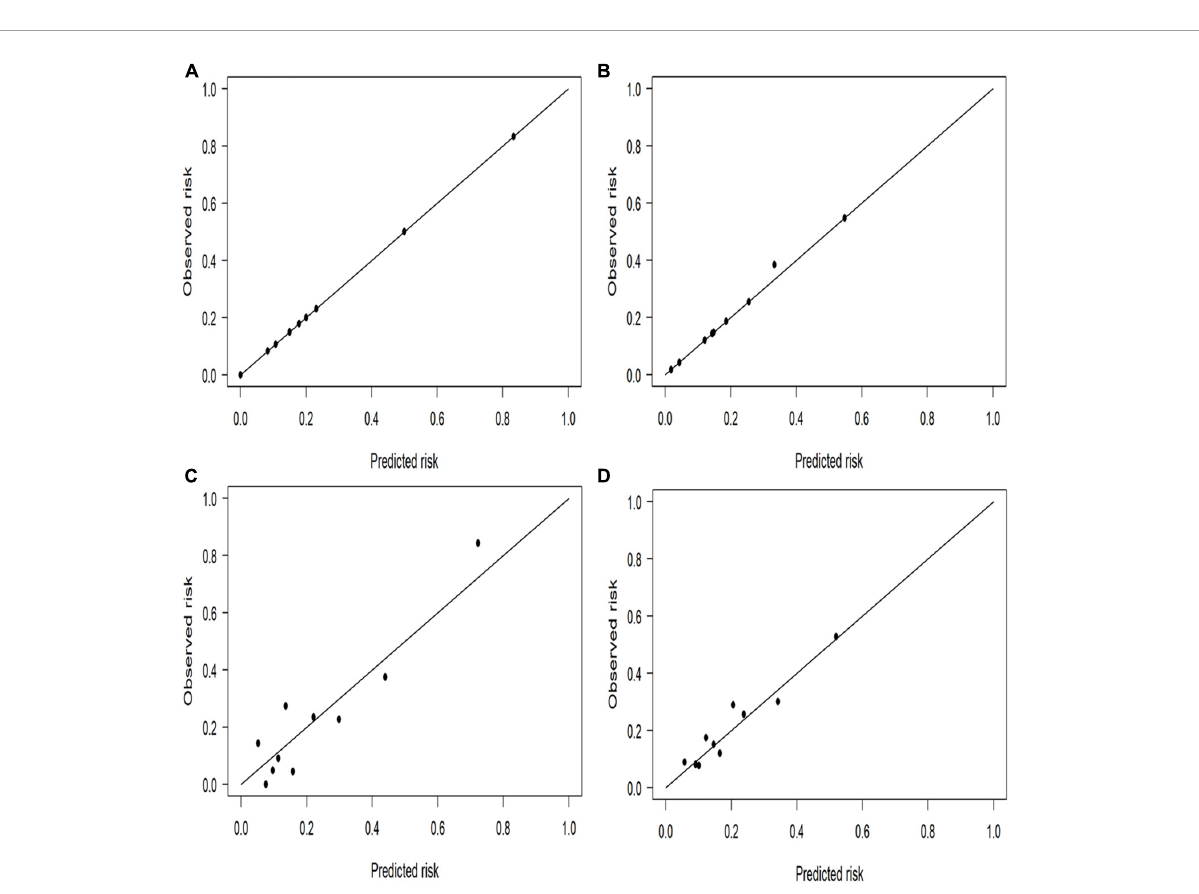
FIGURE4 Calibration plots for the four prediction models in both cohorts. The perfect prediction should be on the 45-degree line. The calibration plots showed that the predicted risk of ischemic stroke (IS) agreed well with the observed risk, in either Bayesian network model of (A) test and (B) training datasets, or in logistic regression model of (C) test and (D) training